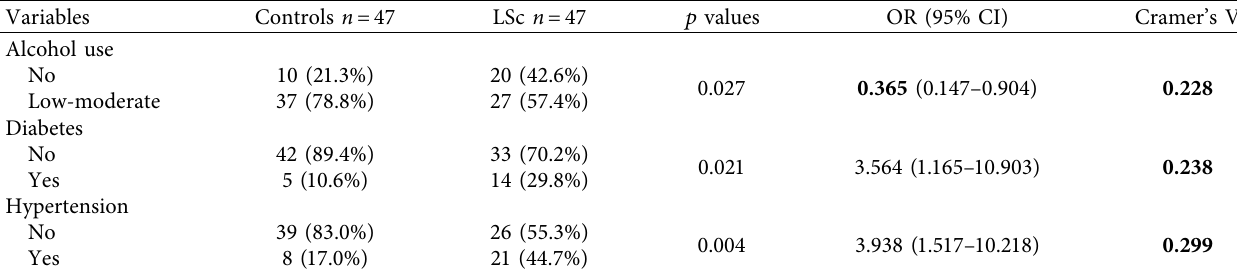
Table 2: Inferential statistics comparing LSc determinants for study participants ( N � 94).